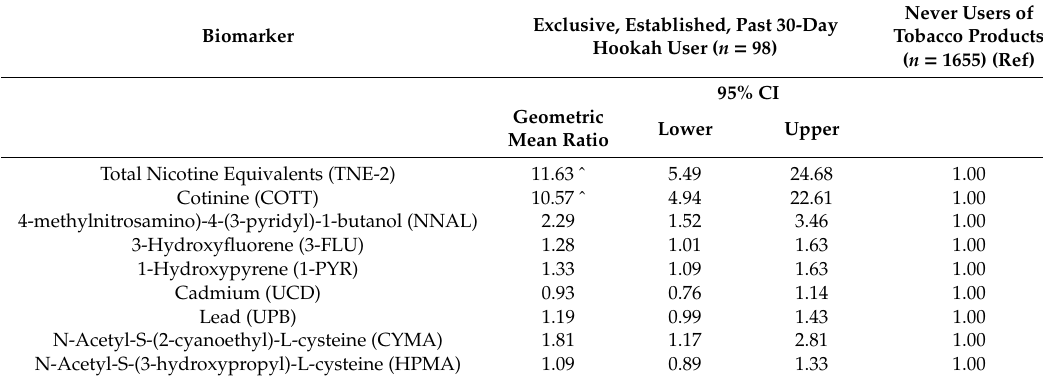
Table 4. Adjusted geometric mean ratios for urinary biomarkers of exposure by hookah use status vs. no tobacco